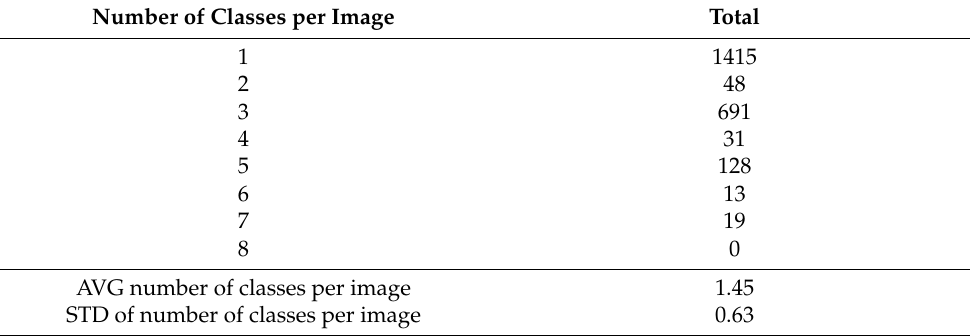
Table 3. Extent of disease co-occurrence in the In-field (IF)